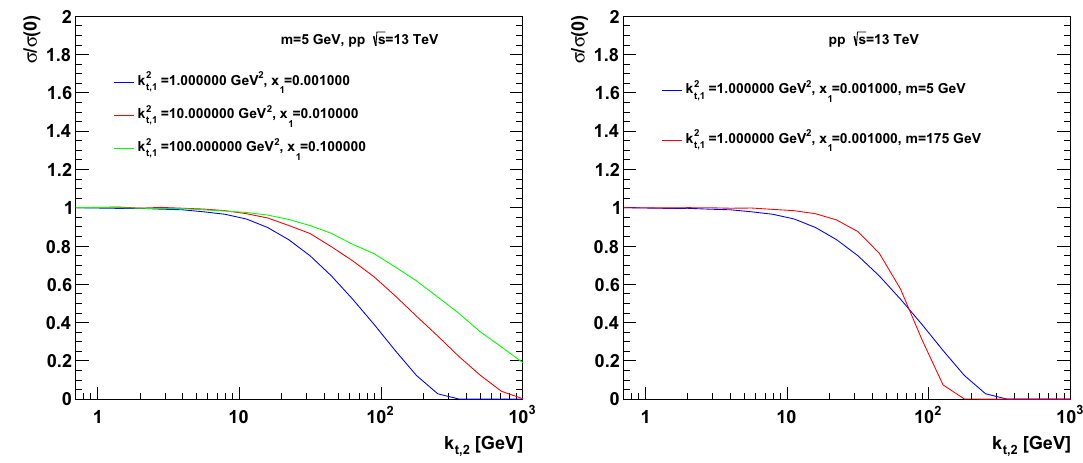
√ s = 13000 GeV. (Left)